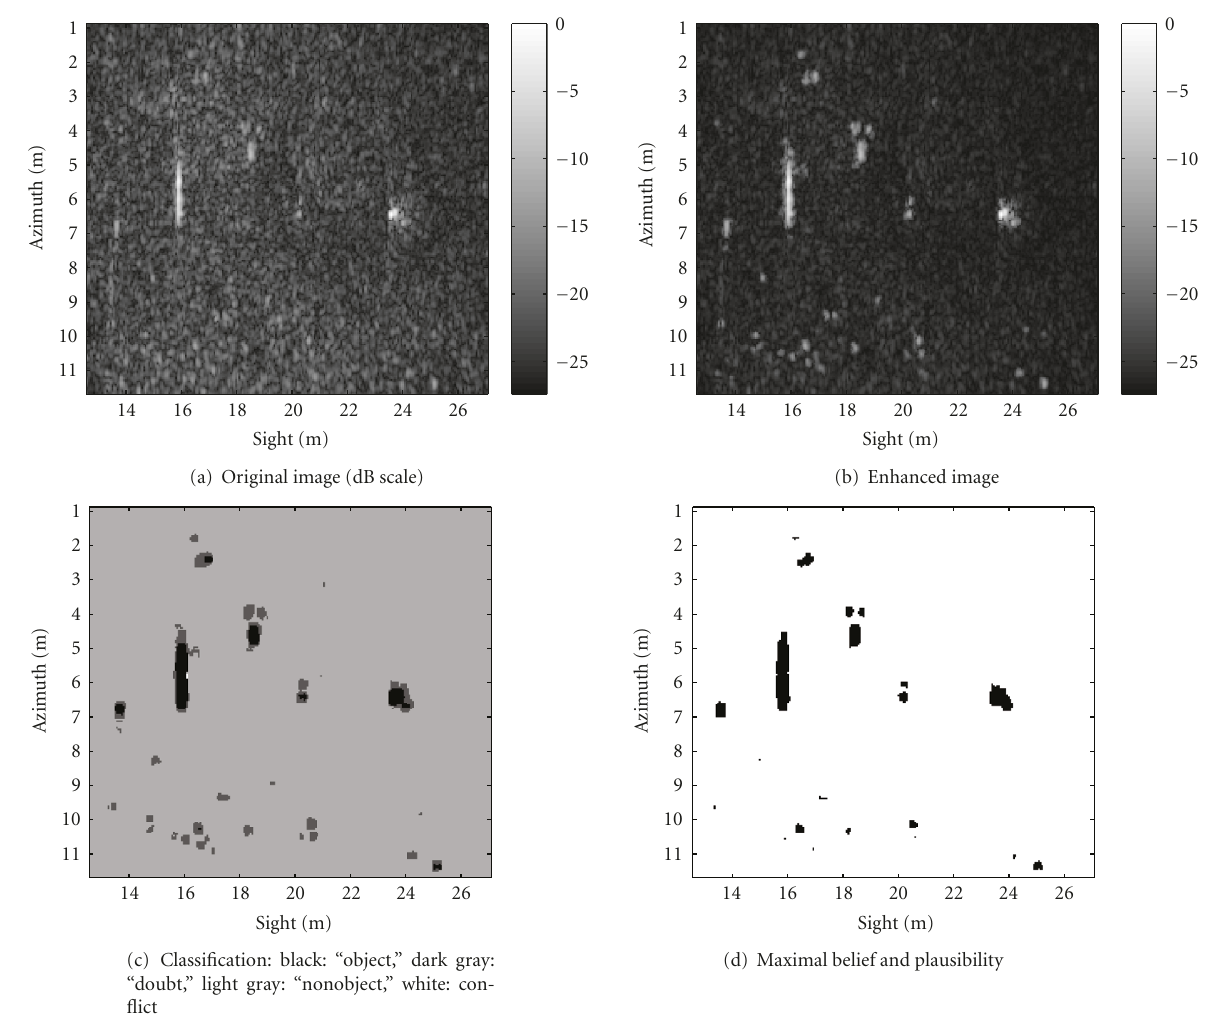
Figure 10: Presentation of the fusion results—image